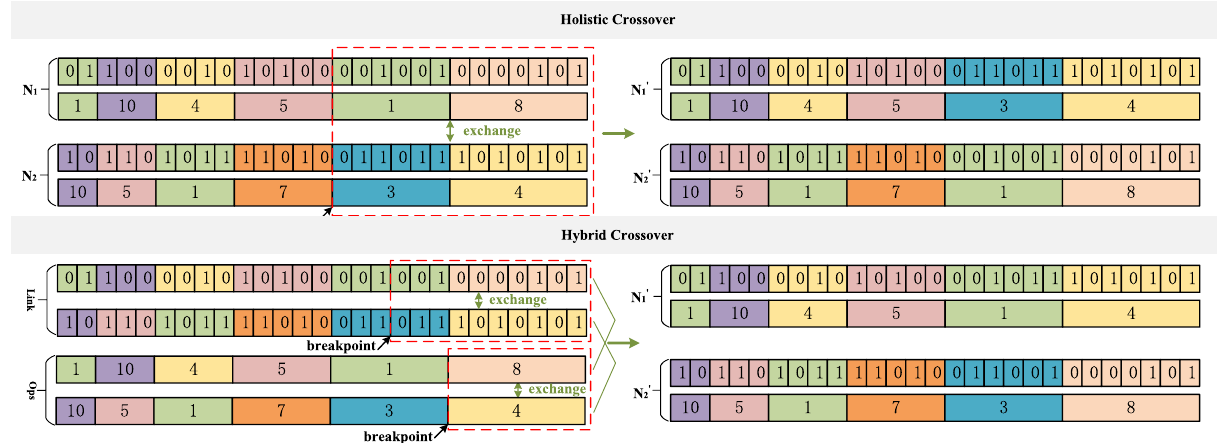
Fig. 6 The proposed crossover operator. Illustrative example of holistic crossover and hybrid crossover between normal cells N 1 and N 2 in two parent